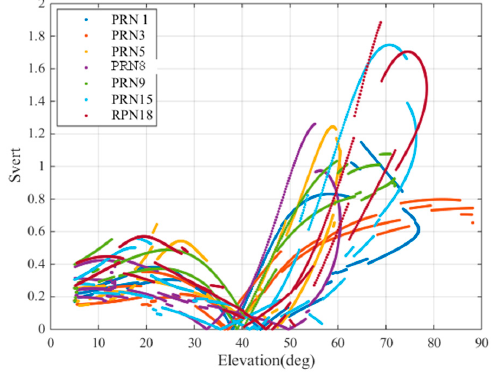
Figure 15. vert s values at different elevation angles. Figure 15. s vert values at different elevation